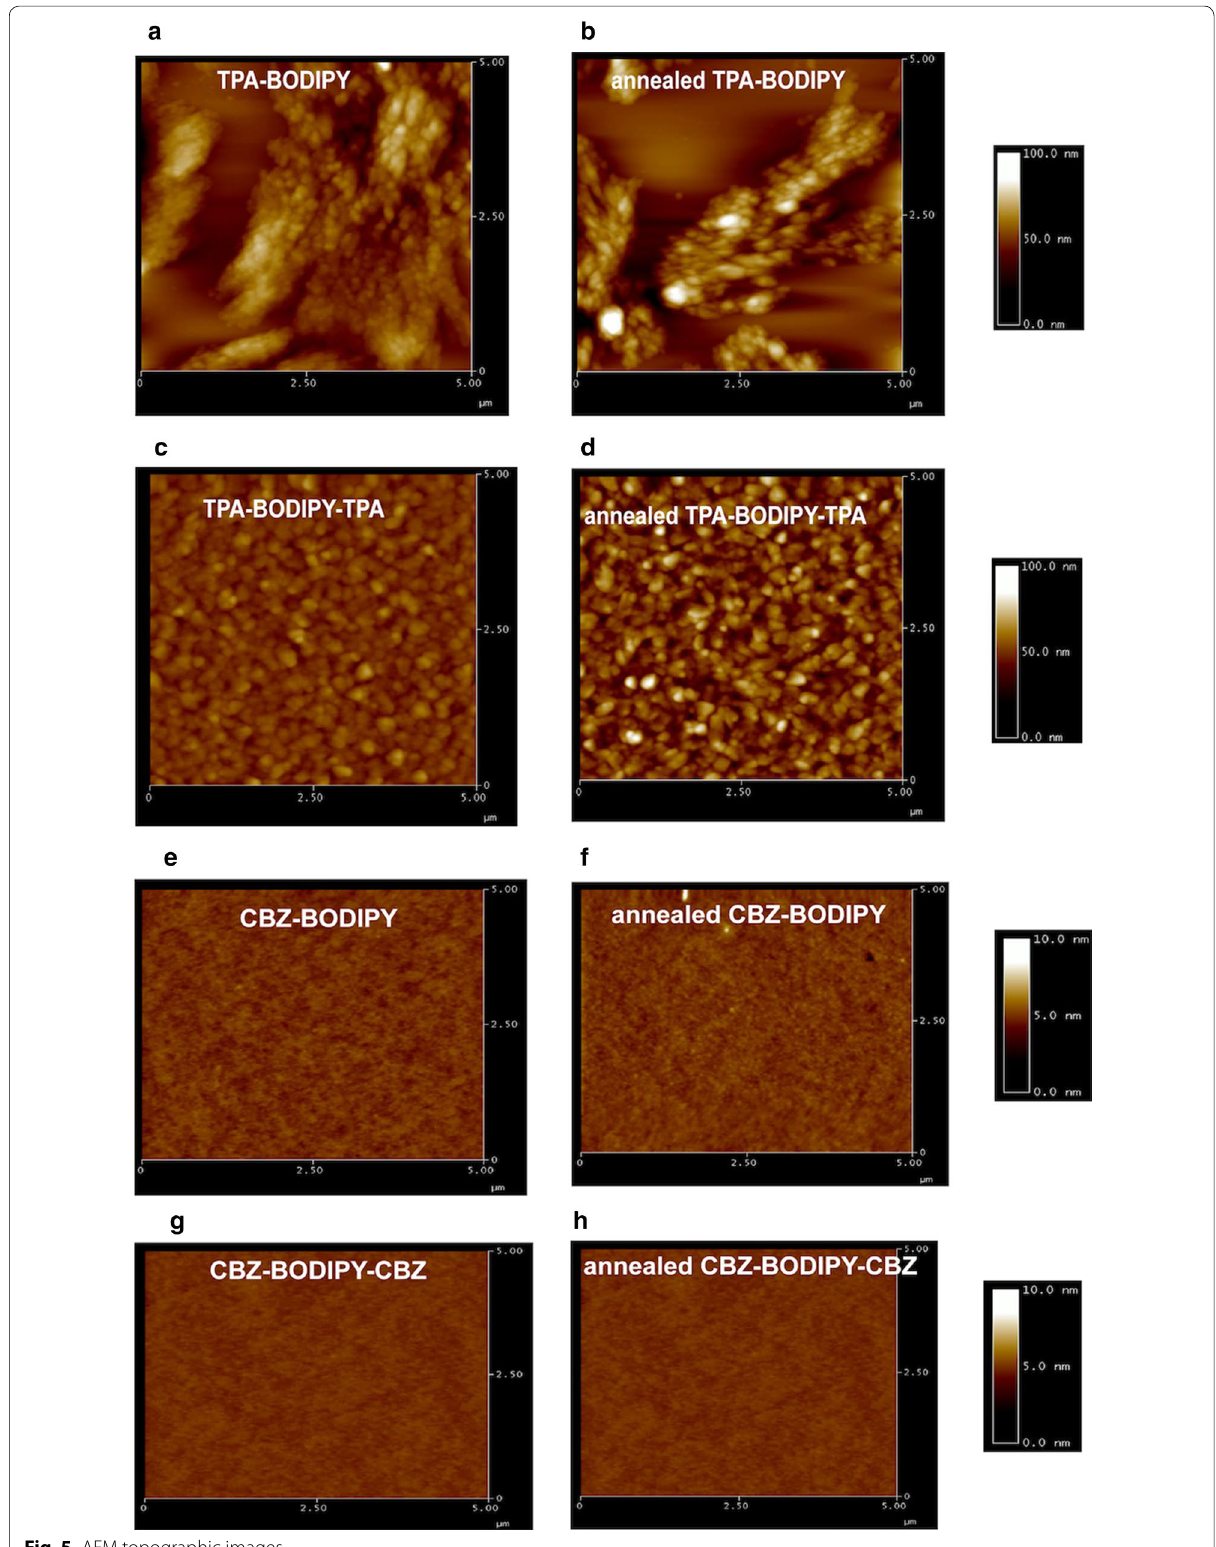
Fig. 5 AFM topographic